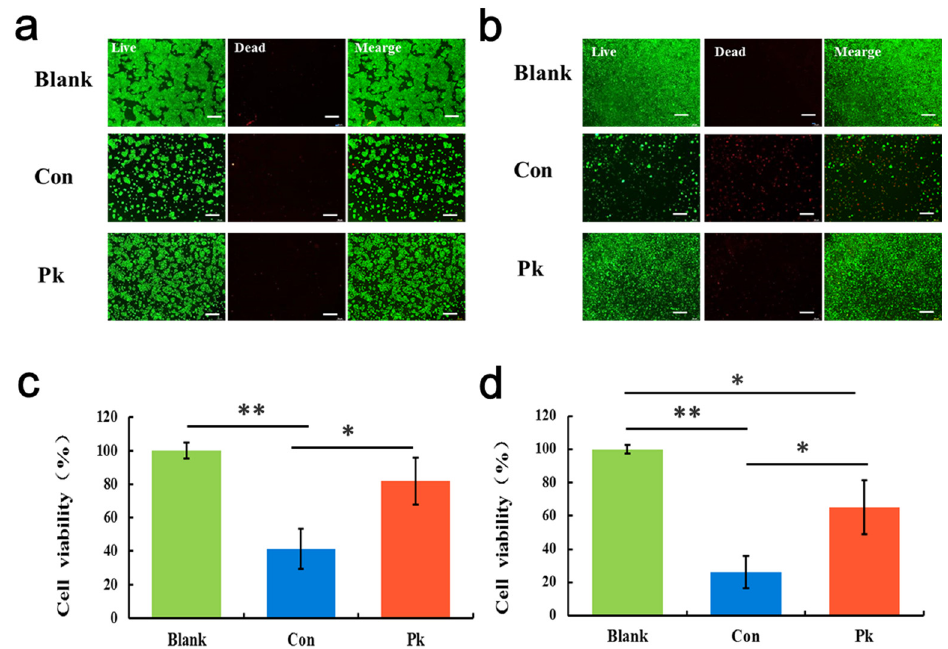
Figure 7. Effects of 5-FU on the viability of target cells on chip with different drug administration regimens. ( a ) HPAEpiC and ( b ) A549 cells were exposed to 5-FU (20 μ g/mL) for 2 days under Blank, Con, and Pk groups, respectively. The cell viability was examined by the Live (green)/Dead (red) kit. Bars: 100 μ m. Quantitative analysis of cell viability in ( c ) HPAEpiC and ( d ) A549 cells after treatment with 5-FU (20 μ g/mL) for 2 days using CCK-8 kit. N = 3, * P < 0.05, ** P < 0.01.